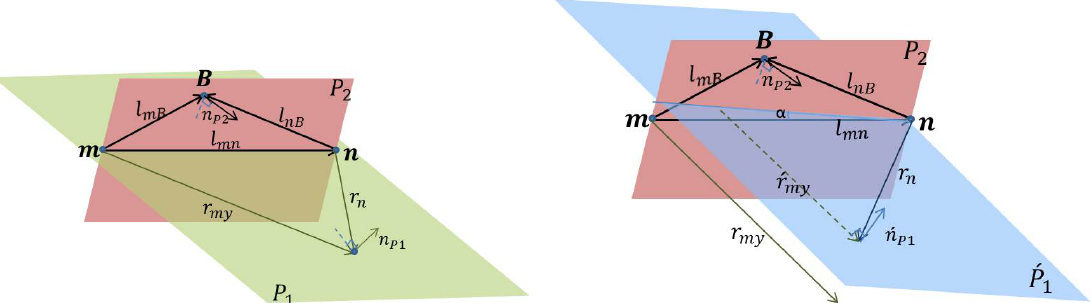
(a) Idealized geometry with intersecting joint axes at hip and (b) Realistic geometry with skew joint axes. knee. Figure 3: Illustration of the constraints formulated in (15): The left figure shows the idealized geometry, which is the basis for the constraints. It approximates the more realistic setup in the right figure with skew joint axes, leading to the plane ˆ P 1 . The latter can be assumed to have a small angle α with respect to the ideal plane P 1 .